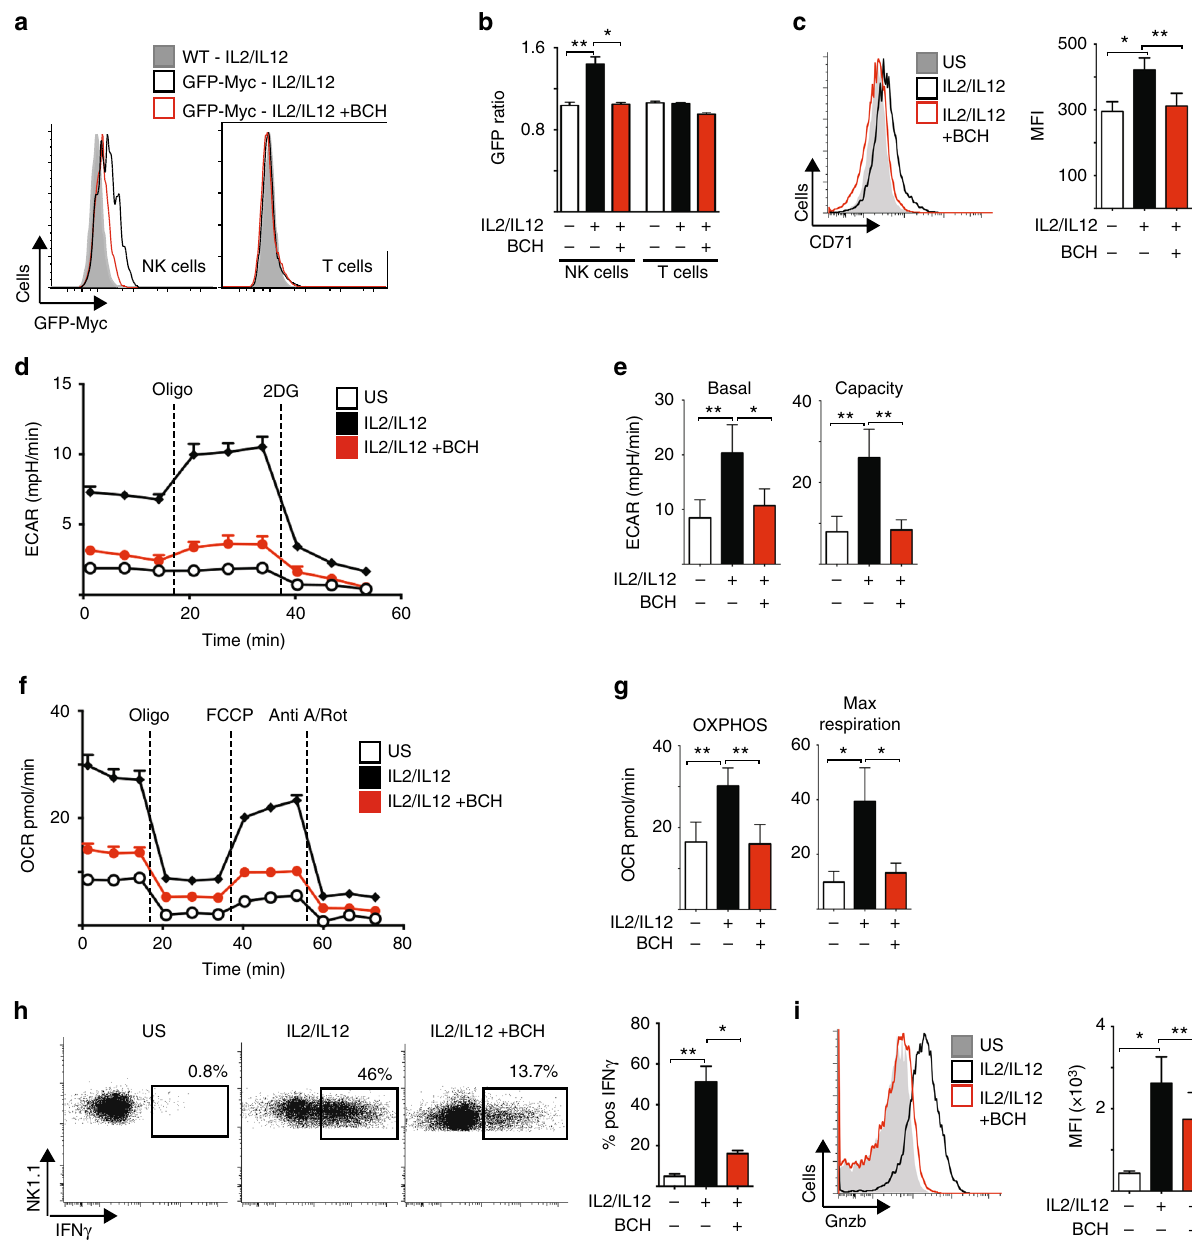
Fig. 6 cMyc is required for splenic NK cell metabolic and functional responses. a , b Ex vivo splenic NK cells and T cells were isolated from CD45.2 GFP-Myc reporter mice or CD45.1 WT mice, mixed in a 1:1 ratio and activated for 18 h with IL-2/12 in the presence or absence of BCH. The ratio of fl uorescence in CD45.2 and CD45.1 cells was calculated to give a measure of cMyc expression (CD45.2 GFP-Myc) adjusted for auto fl uorescence (CD45.1 WT). c – i Ex vivo NK cells were left unstimulated (US) or were activated for 18 h with IL-2/12 in the presence or absence of BCH. c Flow cytometry was used to measure the expression of CD71. d , e Analysis of NK cell extracellular acidi fi cation rate (ECAR) to assess basal glycolytic rate and glycolytic capacity. f , g Analysis of NK cell oxygen consumption rate (OCR) to assess rates of OXPHOS and maximal respiration. Flow cytometry was used to measure the expression of IFN γ ( h ) and granzyme B ( i ). Data are mean ± s.e.m. of 5 ( b ) or 6 ( c, e , g-i ) or representative of 5 ( a ) or 6 ( d , f , h , i ) mice. d – g Data were normalised to 200,000 cells. Statistical analysis was performed using a one-way ANOVA with Tukey post test ( b , c , e , g , h , i ); * p < 0.05, ** p < 0.01. Oligo oligomycin, 2DG 2- deoxyglucose, Anti A, antimycin A, Rot rotenone, FCCP carbonyl cyanide-4-(tri fl